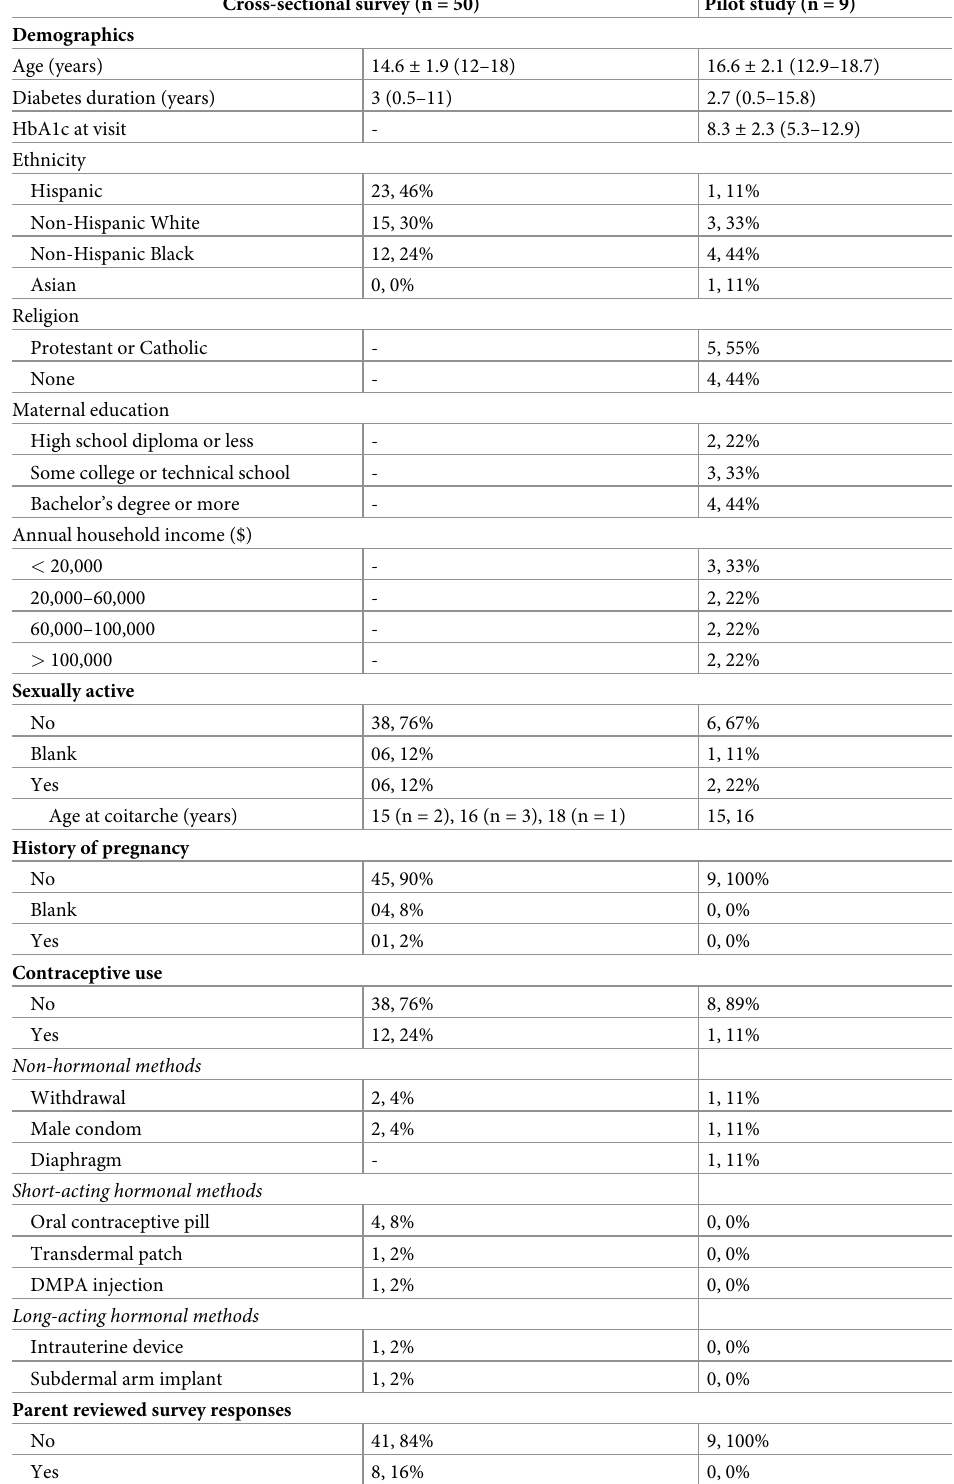
Table 2. Adolescent characteristics. Shown as N, % or median (range) or mean ± SD